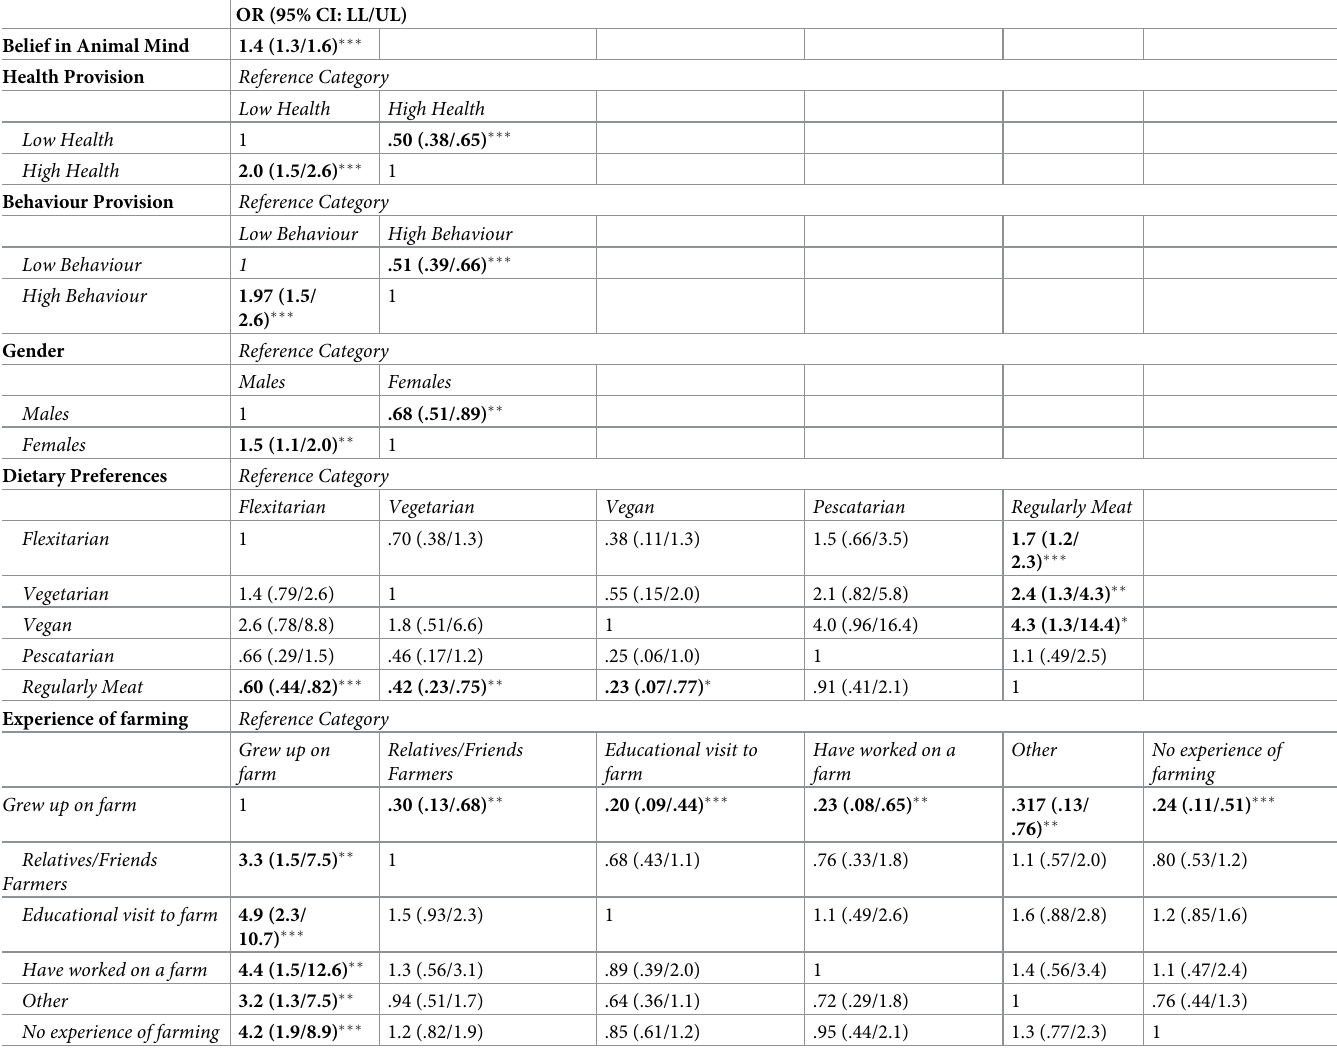
Table 5. Odds ratios of significant predictors of ratings of the importance of promoting natural